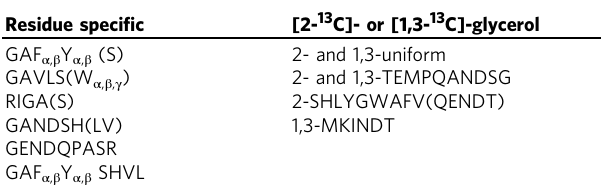
samples produced for sequence-speci fi c assignments